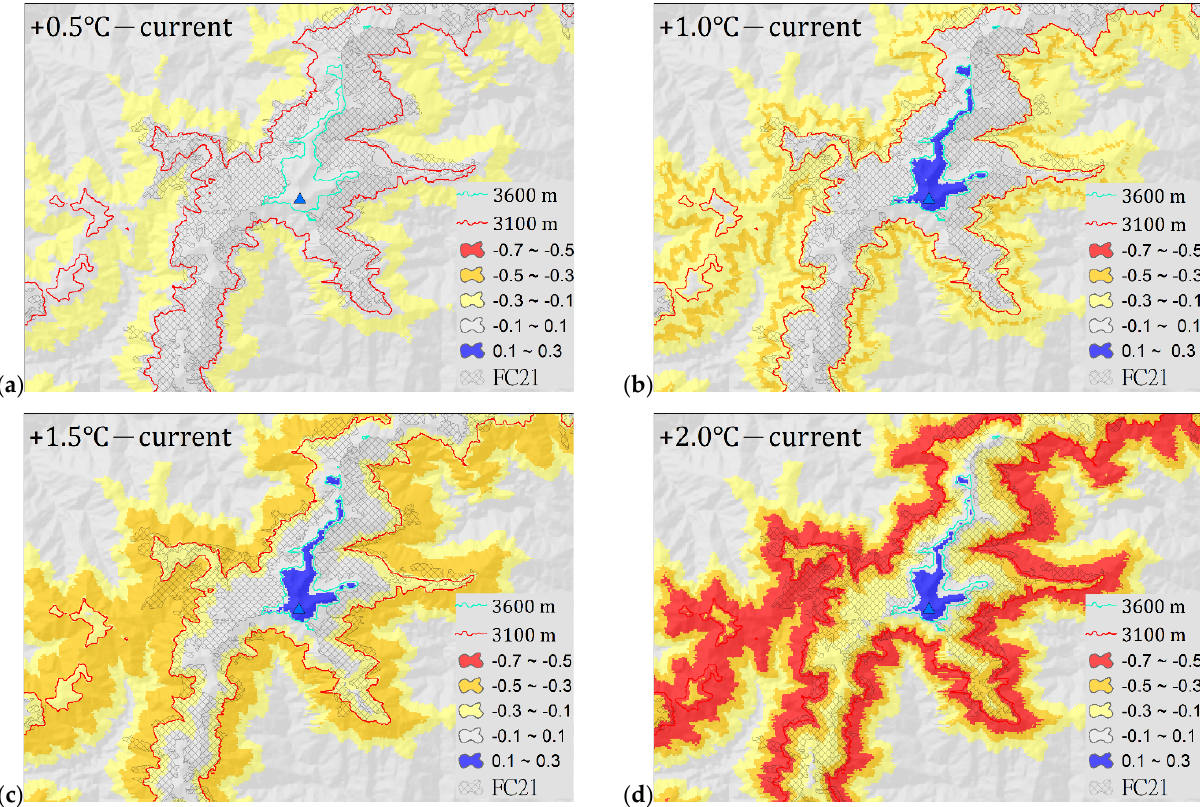
Figure 6. Loss (warm color) and gain (blue) of A. kawakamii habitat areas on Mount Xue under the +0.5~+2.0 °C warming scenarios: ( a ) +0.5, ( b ) +1.0, ( c ) +1.5, and ( d ) +2.0 °C. +0.5~+2.0 ◦ C warming scenarios: ( a ) +0.5, ( b ) +1.0, ( c ) +1.5, and ( d ) +2.0 ◦